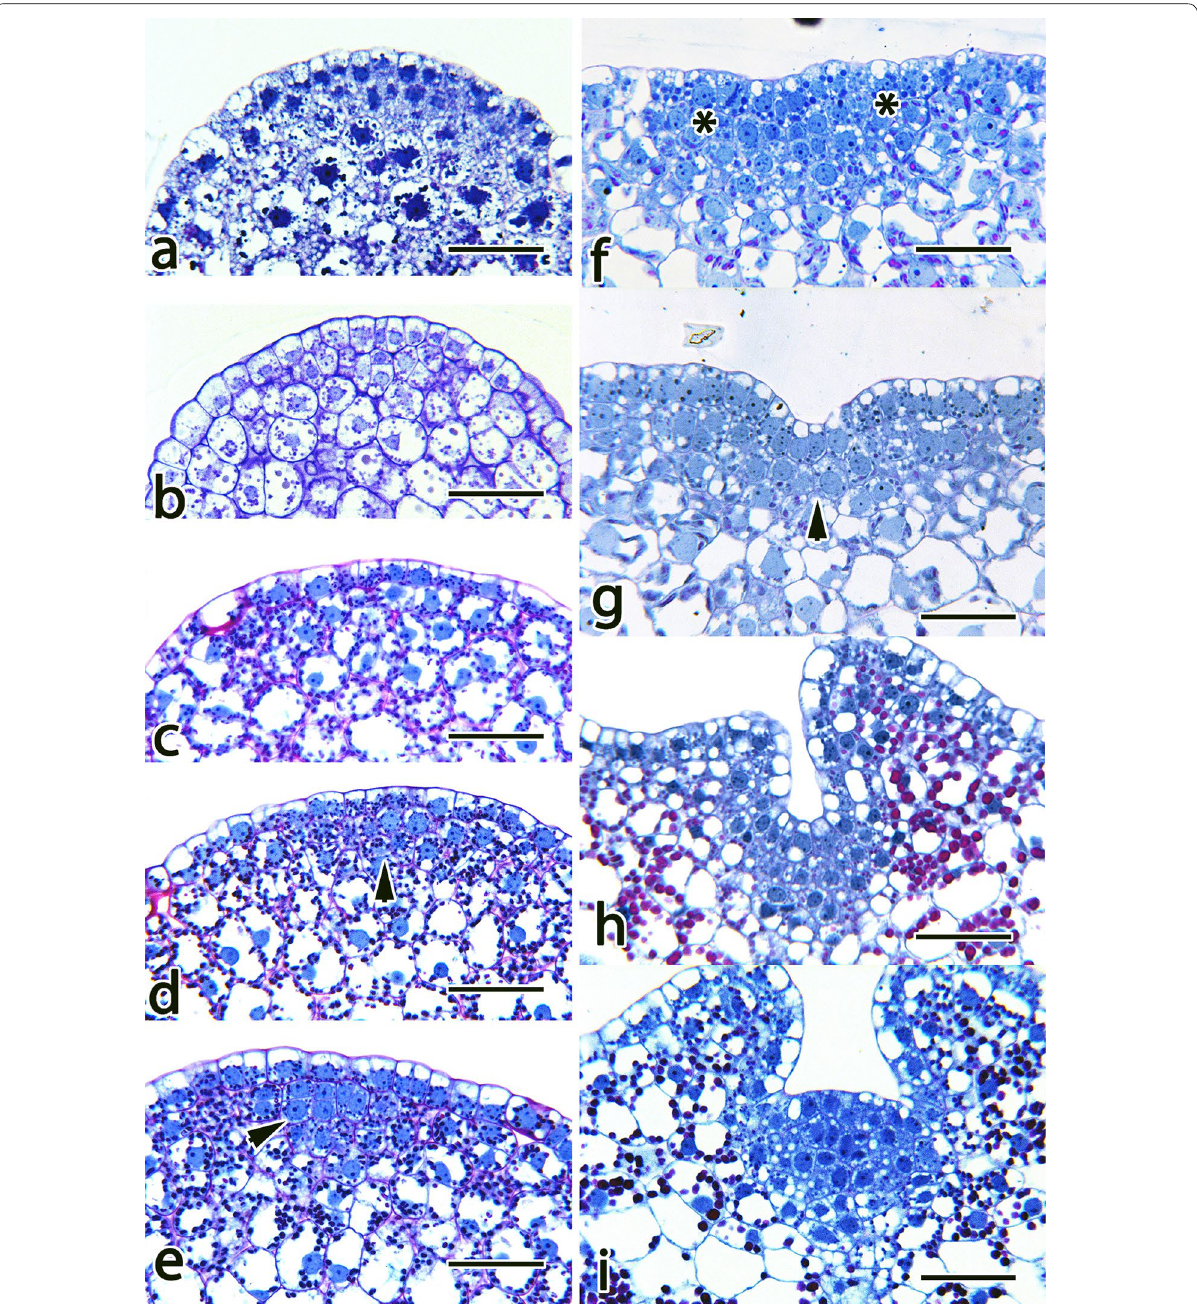
Fig. 1 Shows the structural ontogeny of a shoot apical meristem in Epidendrum ibaguense . a At the time of seed germination, the embryo cells have abundant storage product deposits. b Within 96 h, storage products have been mobilized and cells are becoming vacuolated; judging from the cell profile of the apical layer, mitotic divisions have begun. c Approximately 7 days after germination, protocorms start to turn green, plastids become abundant with starch within protocorm cells. Protocorm cells at the future shoot pole, albeit smaller, have similar cytological features. d Soon after, future shoot meristem cells ( arrowhead ) can be identified as they are smaller in size and with a large nucleus to cytoplasm ratio. e The SAM initials ( arrowhead ) take on a square - shape and starch granules become less abundant. These features clearly mark the structural identity of SAM cells. f The SAM increases in size and starch granules remain less abundant when compare to the rest of the protocorm cells. In the peripheral region of the SAM, the cells ( Asterisk ) start to expand. g Continual expansion of peripheral meristem cells result in the formation of a protrusion; this results in the formation of a ‘dimple’ with the SAM cells ( arrowhead ) located at the depression. h The SAM continues to grow in size, surrounded by a developing leaf primordium. i The SAM in a mature plantlet takes on a slightly domed-shaped structure, forming leaf primordia at a regular interval. All scale bar 50 =